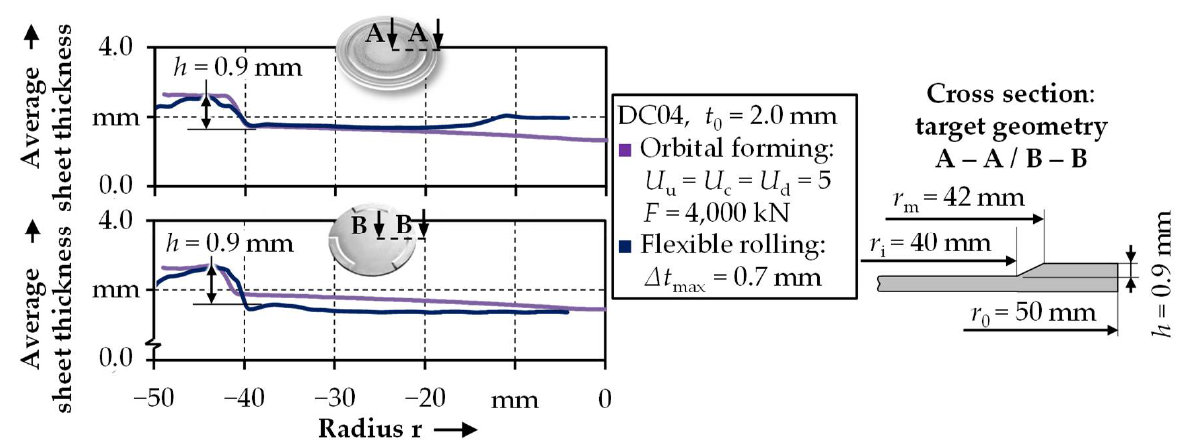
Figure 9. Average sheet thicknesses for the orbital forming and flexible rolling processes for different geometries.